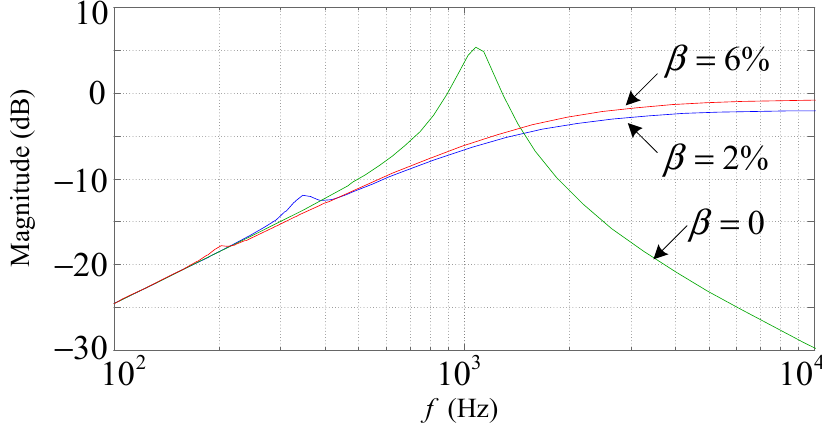
Figure 13. Bode diagram of the hybrid system.